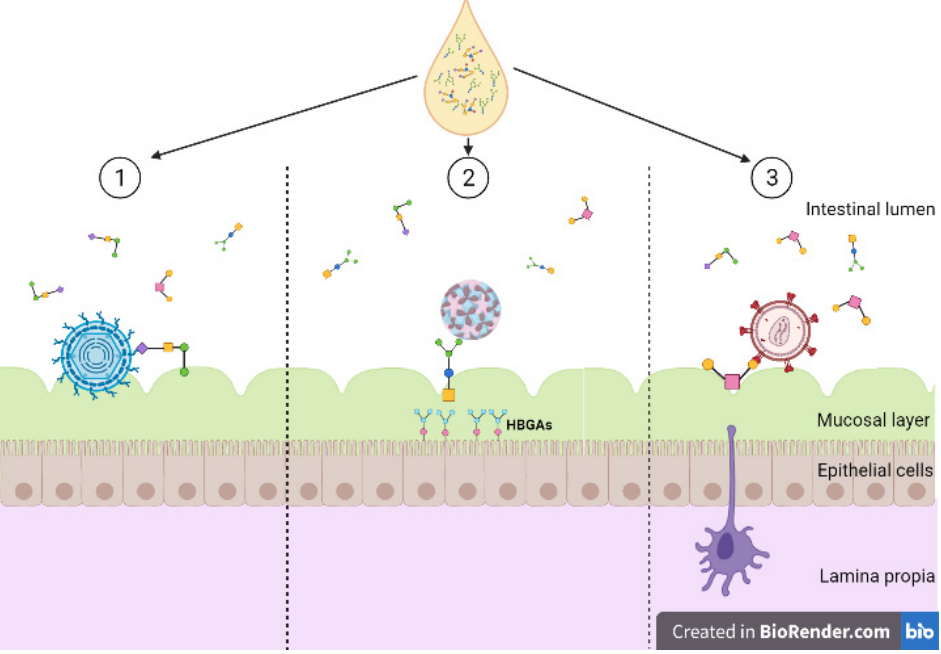
Figure 3. Diversity of human milk oligosaccharide (HMO) interference against viral entry. ( 1 ) HMOs act as soluble decoy receptors for rotavirus, preventing direct binding to host cells; ( 2 ) HMOs mimic histo-blood group antigens (HBGAs), binding to both GI and GII HBGA pockets; ( 3 ) HMOs bind to glycoprotein gp120 interfering and preventing viral binding to dendritic cell-SIGN. Created with BioRender.com.